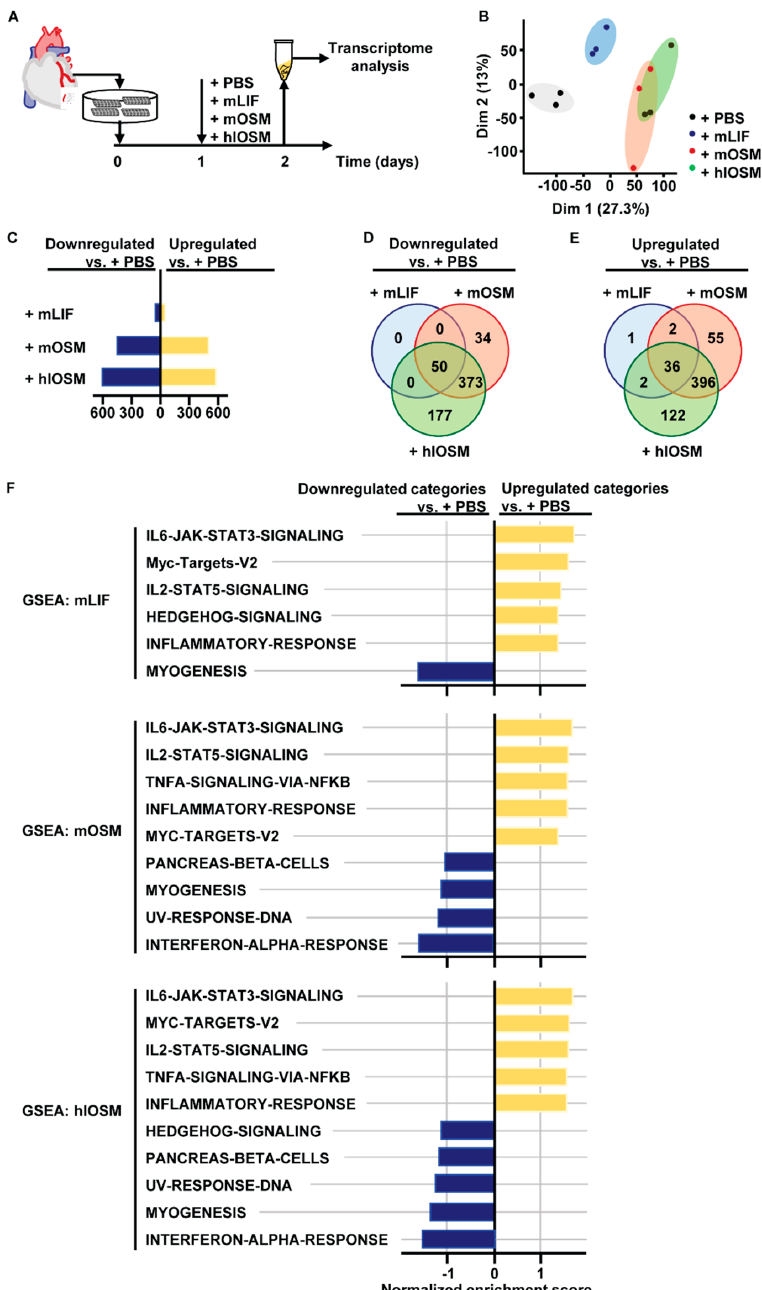
cytes (Figure 2D,E, Supplementary Figure S1). The highest number of genes being exclu- sively up- and down-regulated by a singular cytokine was referred to hlOSM (Figure 2D,E).